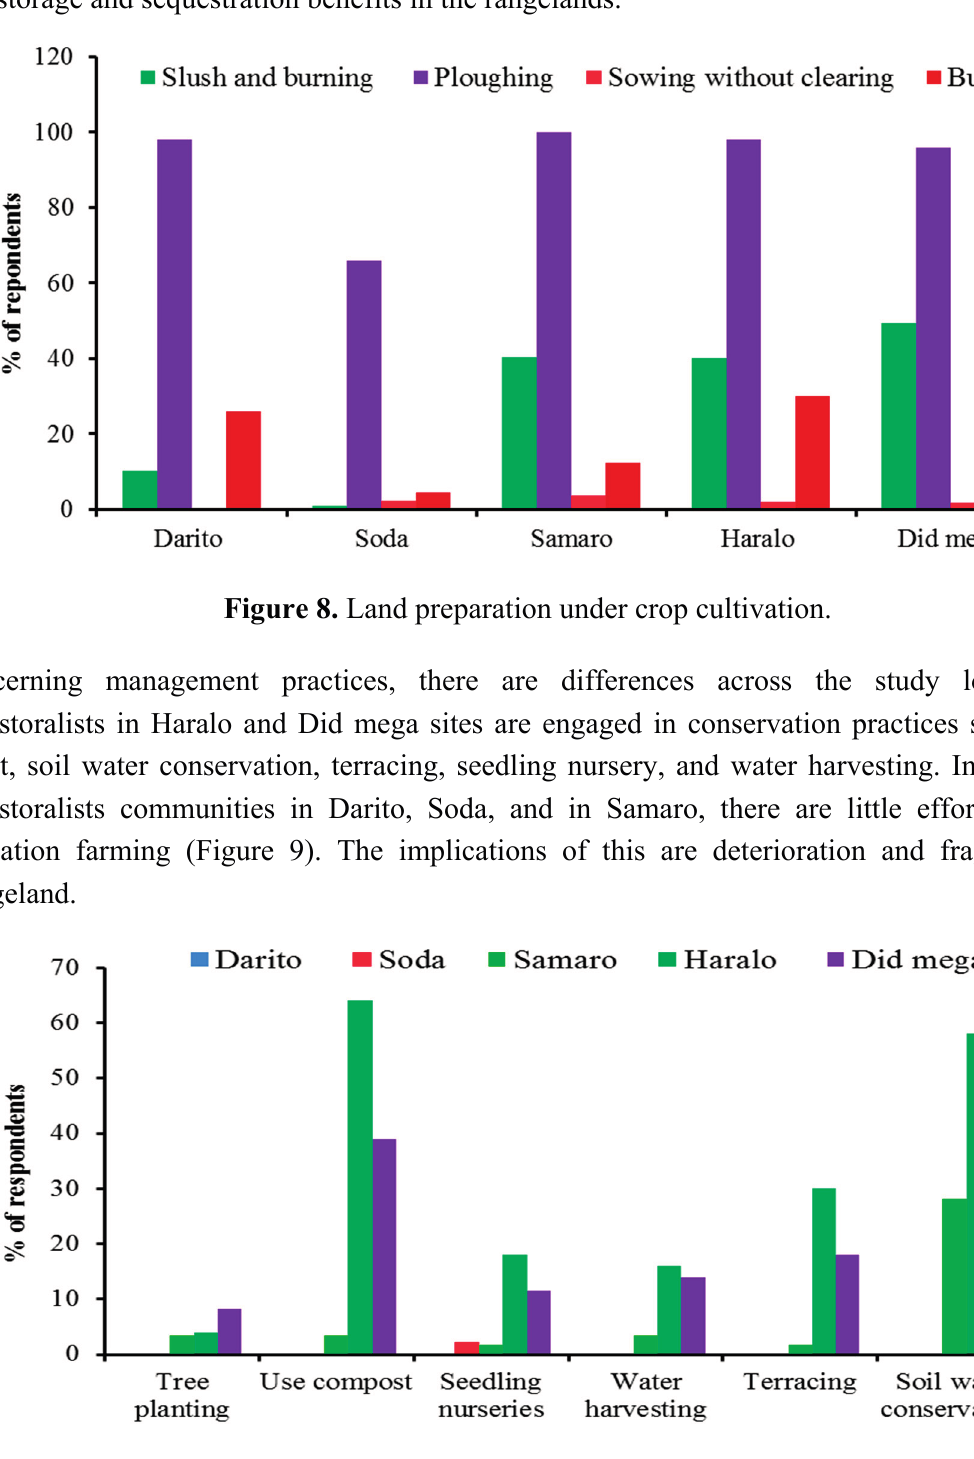
Figure 9. Farming management